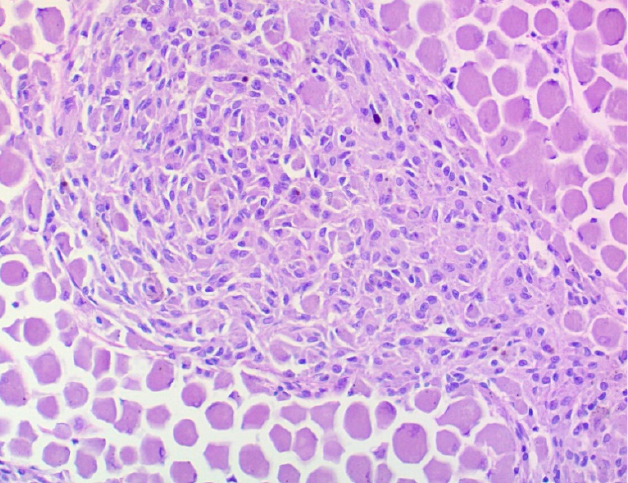
Figure 6. Choroidal melanocytoma: a population of large round cells with a very broad cytoplasm at the edge, and a second spindle cell population with a smaller cytoplasm in the center of the image. No significant atypia or mitoses. Bleaching, 200× magnification.